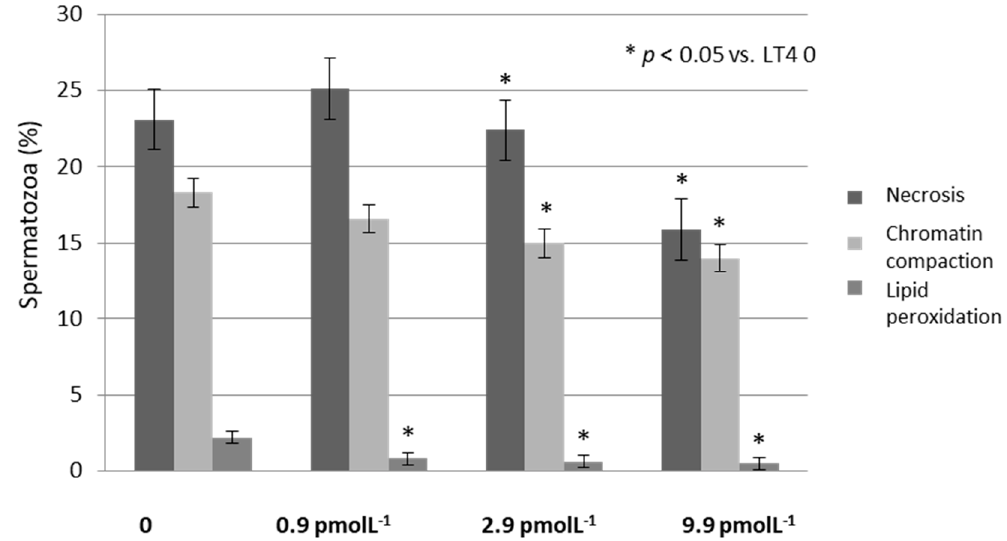
Figure 3. Sperm necrosis, chromatin compactness and lipid peroxidation after incubation with increasing concentrations of levothyroxine (LT4).